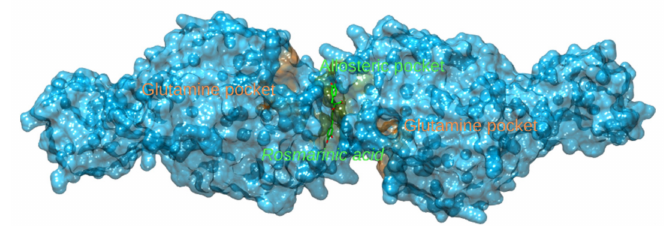
Figure 13. Glutaminase binding sites. Two protomers forming glutaminase are shown on blue surfaces. The main glutamine substrate-binding pockets are highlighted in orange surfaces, whereas rosmarinic acid (carbons denoted with green sticks) docks into the allosteric binding site (green surfaces) formed between the two glutamase